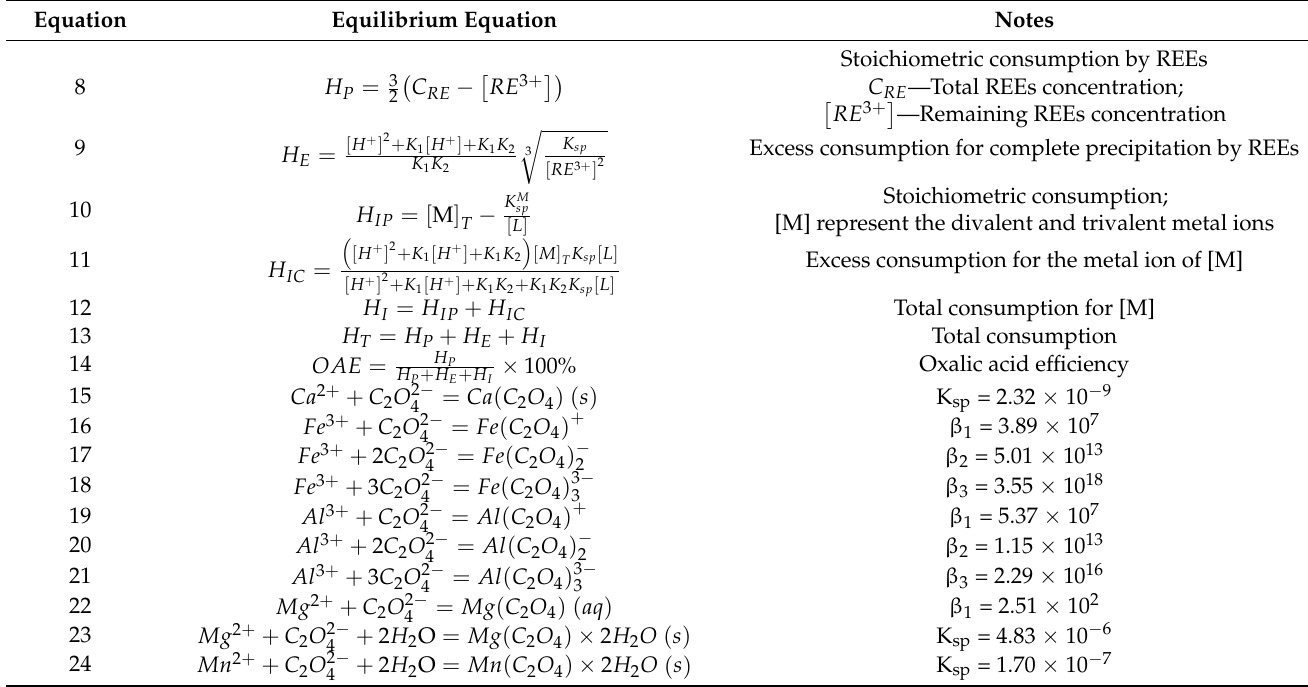
Table 4. Equations used to determine oxalic acid consumption for REE